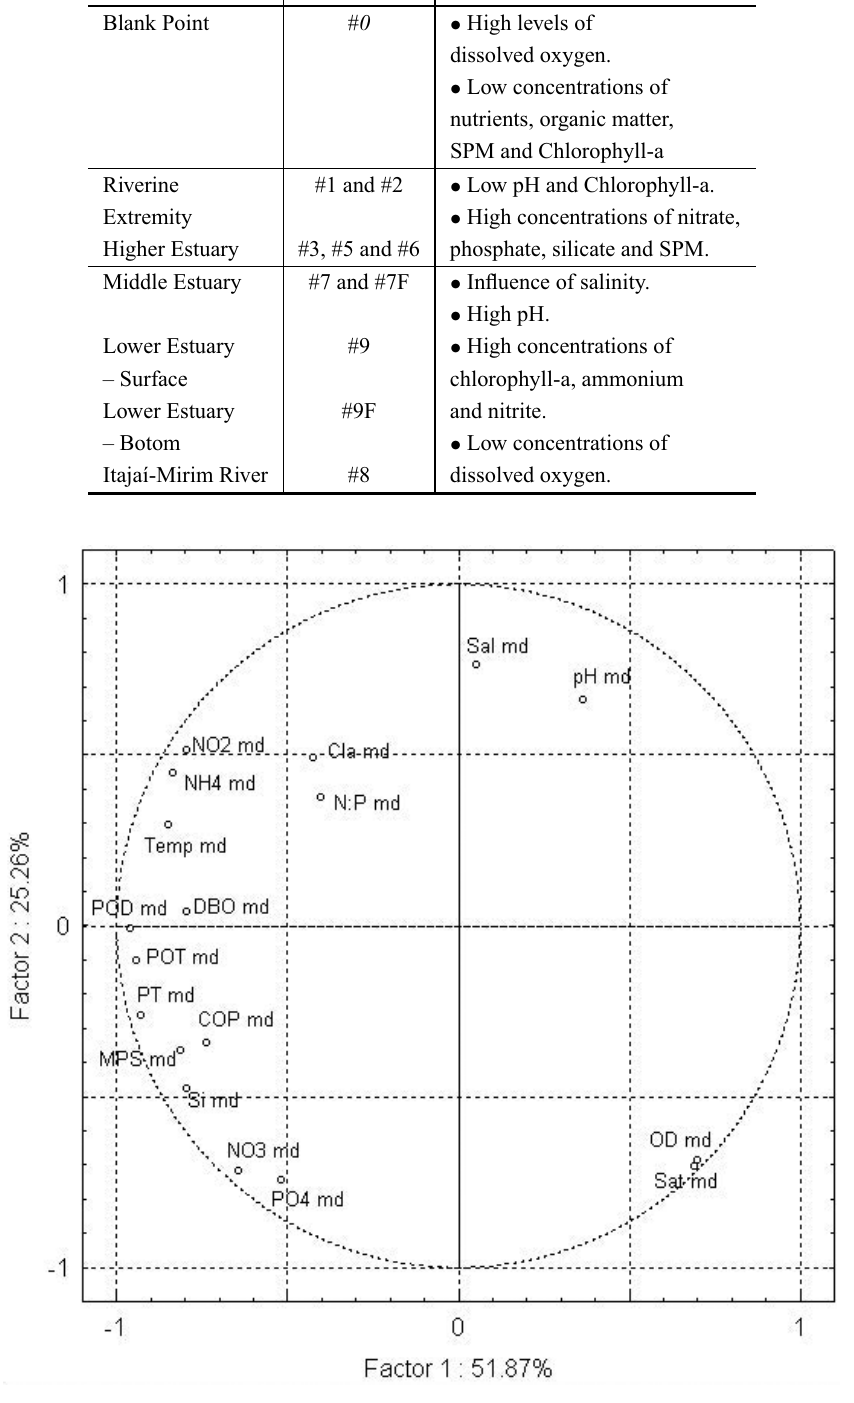
Fig. 7 – Plane formed by axes 1 and 2 of the PCA carried out on the spatial averages, showing the variables (mode R).